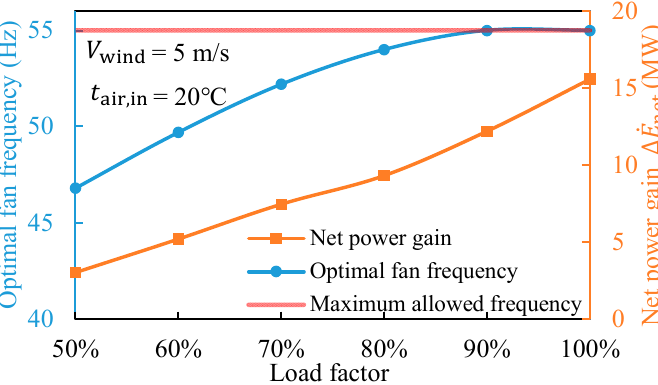
Figure 7. Schematic of the optimal control of air fan frequency based on the cyber layer.